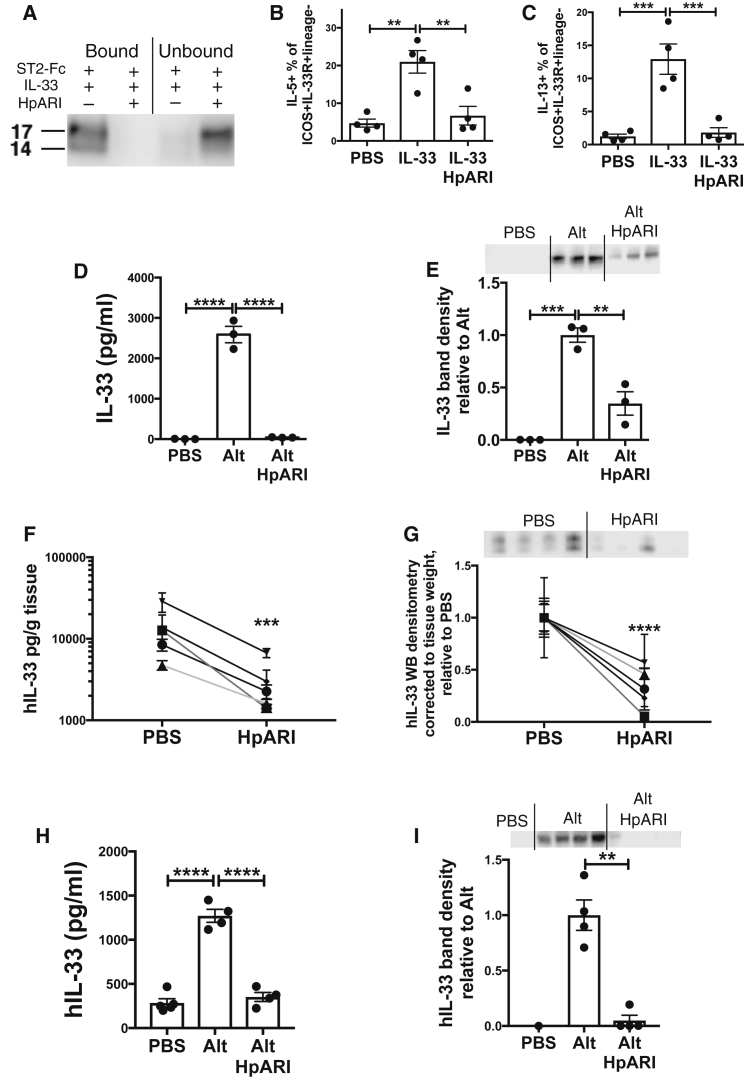
HpARI Blocks IL-33-ST2 Interactions and Inhibits IL-33 Release(A) IL-33 western blot (non-reducing) of ST2-Fc fusion protein immunoprecipitation of recombinant murine IL-33 in the presence or absence of HpARI.(B) Lung ILC2 IL-5 production 24 hr after intranasal administration of recombinant murine IL-33 (200 ng/mouse) with 5 μg HpARI.(C) Lung ILC2 IL-5 production from mice described in (B).(D) Murine IL-33 levels (ELISA) in BAL 15 min after Alternaria allergen and HpARI were intranasally administered.(E) Murine IL-33 western blot (∼20 kDa band and densitometry analysis) of BAL from mice described in (D).(F) Human IL-33 levels (ELISA) in supernatants of human lung explants cultured for 1 hr with HpARI.(G) Human IL-33 western blot (∼20 kDa band and densitometry analysis) of supernatants from human lung explants cultures described in (F).(H) Human IL-33 levels (ELISA) in BAL fluid of human IL-33-transgenic mice, 30 min after Alternaria allergen and HpARI intranasal administration.(I) Human IL-33 western blot (∼20 kDa band and densitometry analysis) of BAL from human IL-33-transgenic mice described in (H).Mouse data (A–E, H–I) representative of 2–4 repeat experiments, each with 3–4 mice per group. Human data (C and D) shows 5 independent subjects. Error bars show SEM.